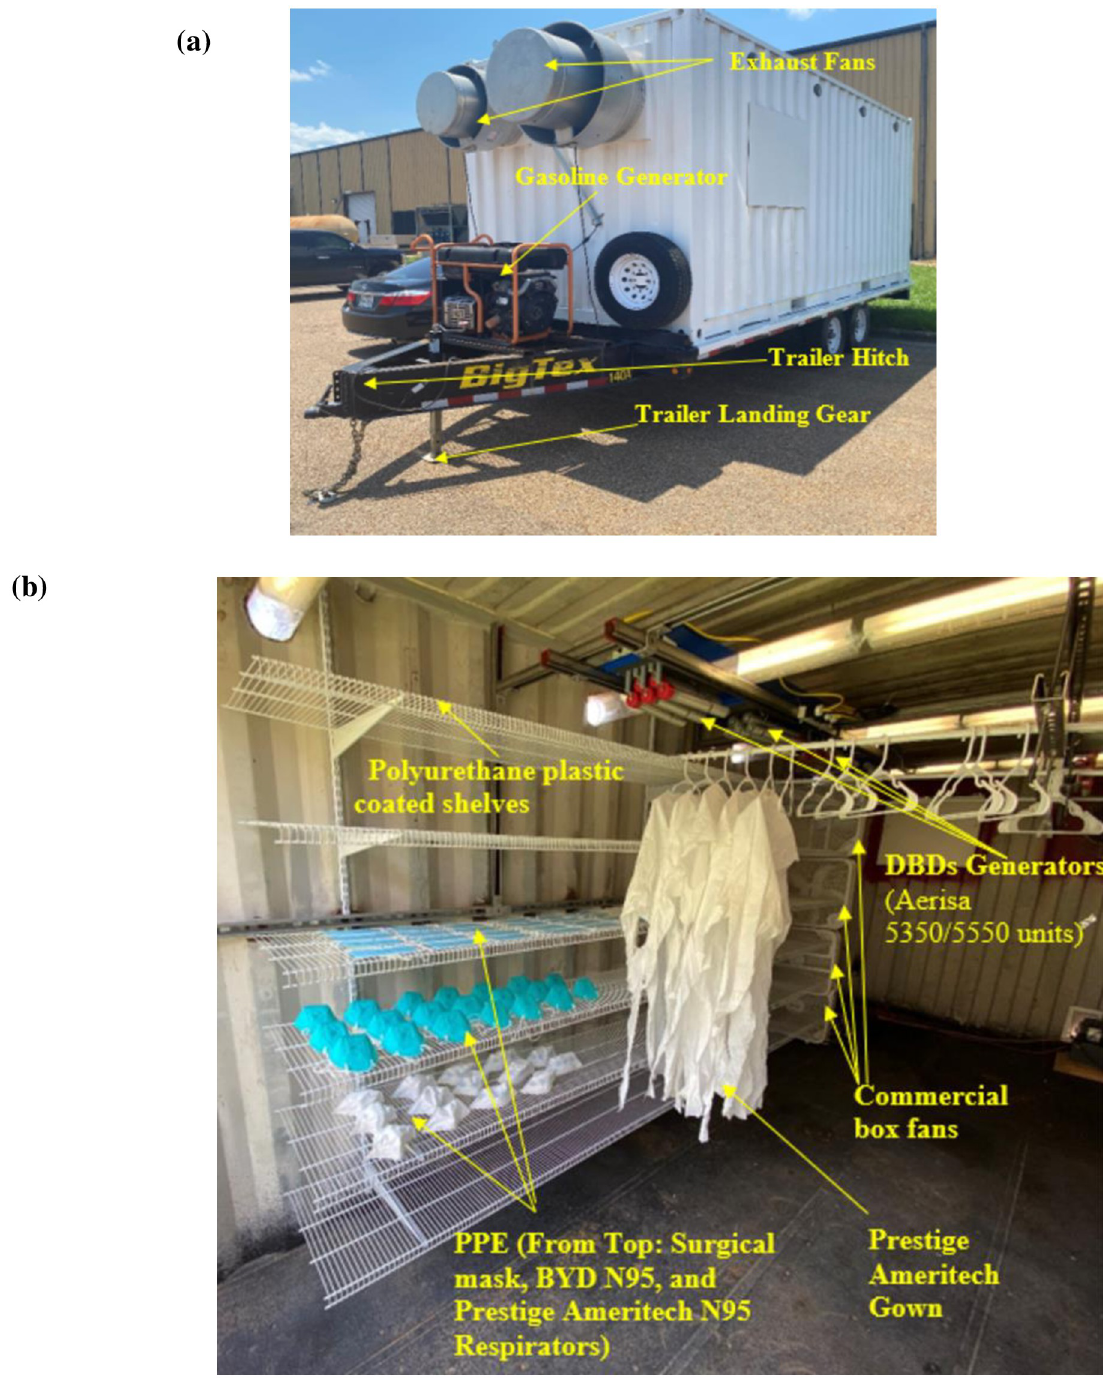
Fig 6. (a) Outside view of the trailer and (b) Inside view of the trailer with PPE (surgical masks, respirators, and gown) arrangement.